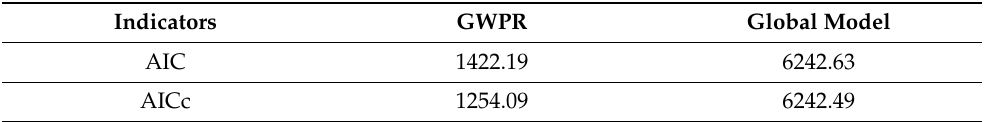
Figure 3. Maps of Harris County census tracts that show local associations between the variables in the final aspatial model and COVID-19 incidence. The local beta coefficients were exponentiated (RR) to show the sensitivity of COVID-19 incidence to a change of 10-unit difference in each of the neighborhood characteristics shown above, specific to each census tract. The middle class (0.99–1.01) crosses 1.0. To simplify interpretation, the same legend was applied to all maps. Values less than 0.99 suggest census tracts where increase in the proportion of the independent variable is associated with decreased RR for COVID-19, while values above 1.01 suggest increased RR for COVID-19 with increased proportion of the independent variable (10-unit increase). Table 6. Comparison between GWPR and global Poisson regression modeling